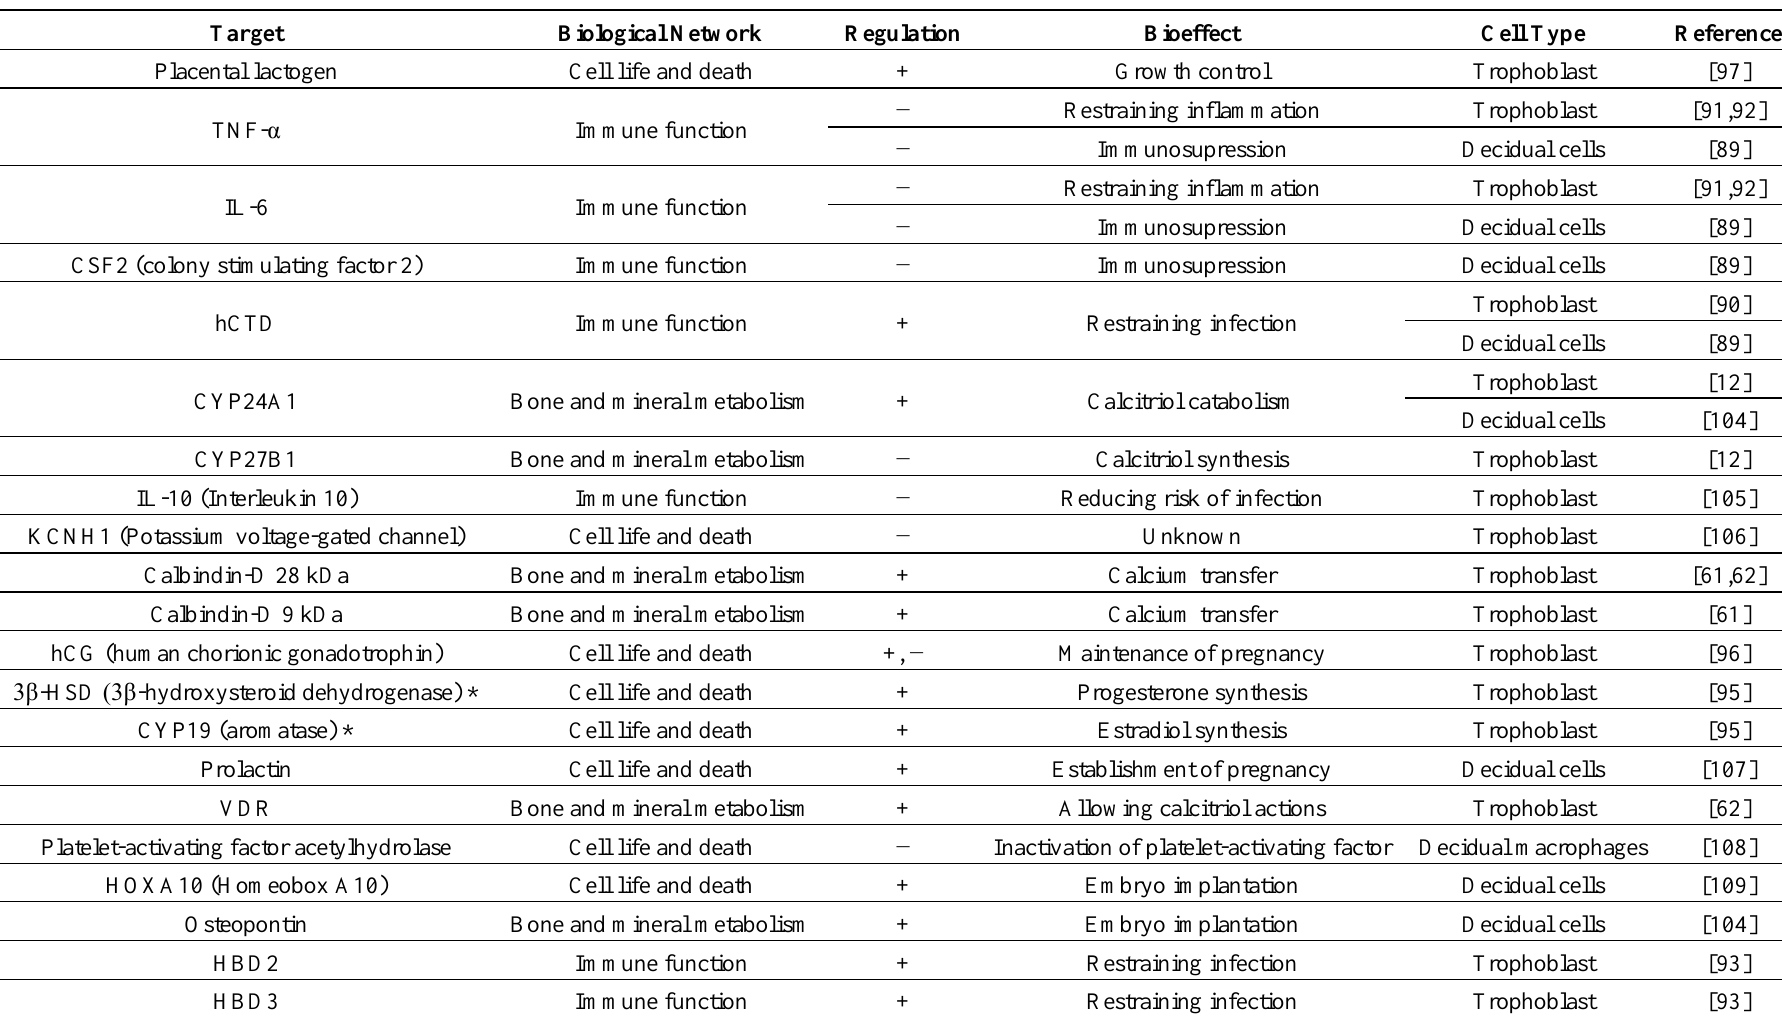
Table 1. Targets modulated by calcitriol in the human placenta (+ = Stimulation; − =